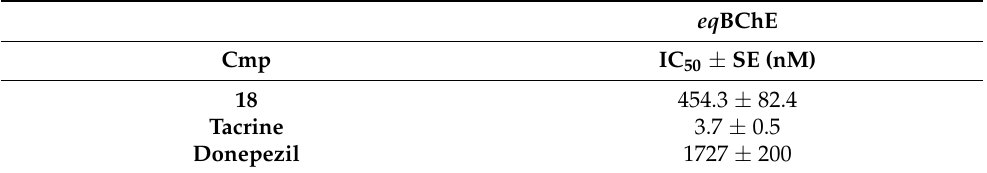
Table 4. IC 50 on eq BChE for compound 18 and for tacrine and donepezil, used as the reference